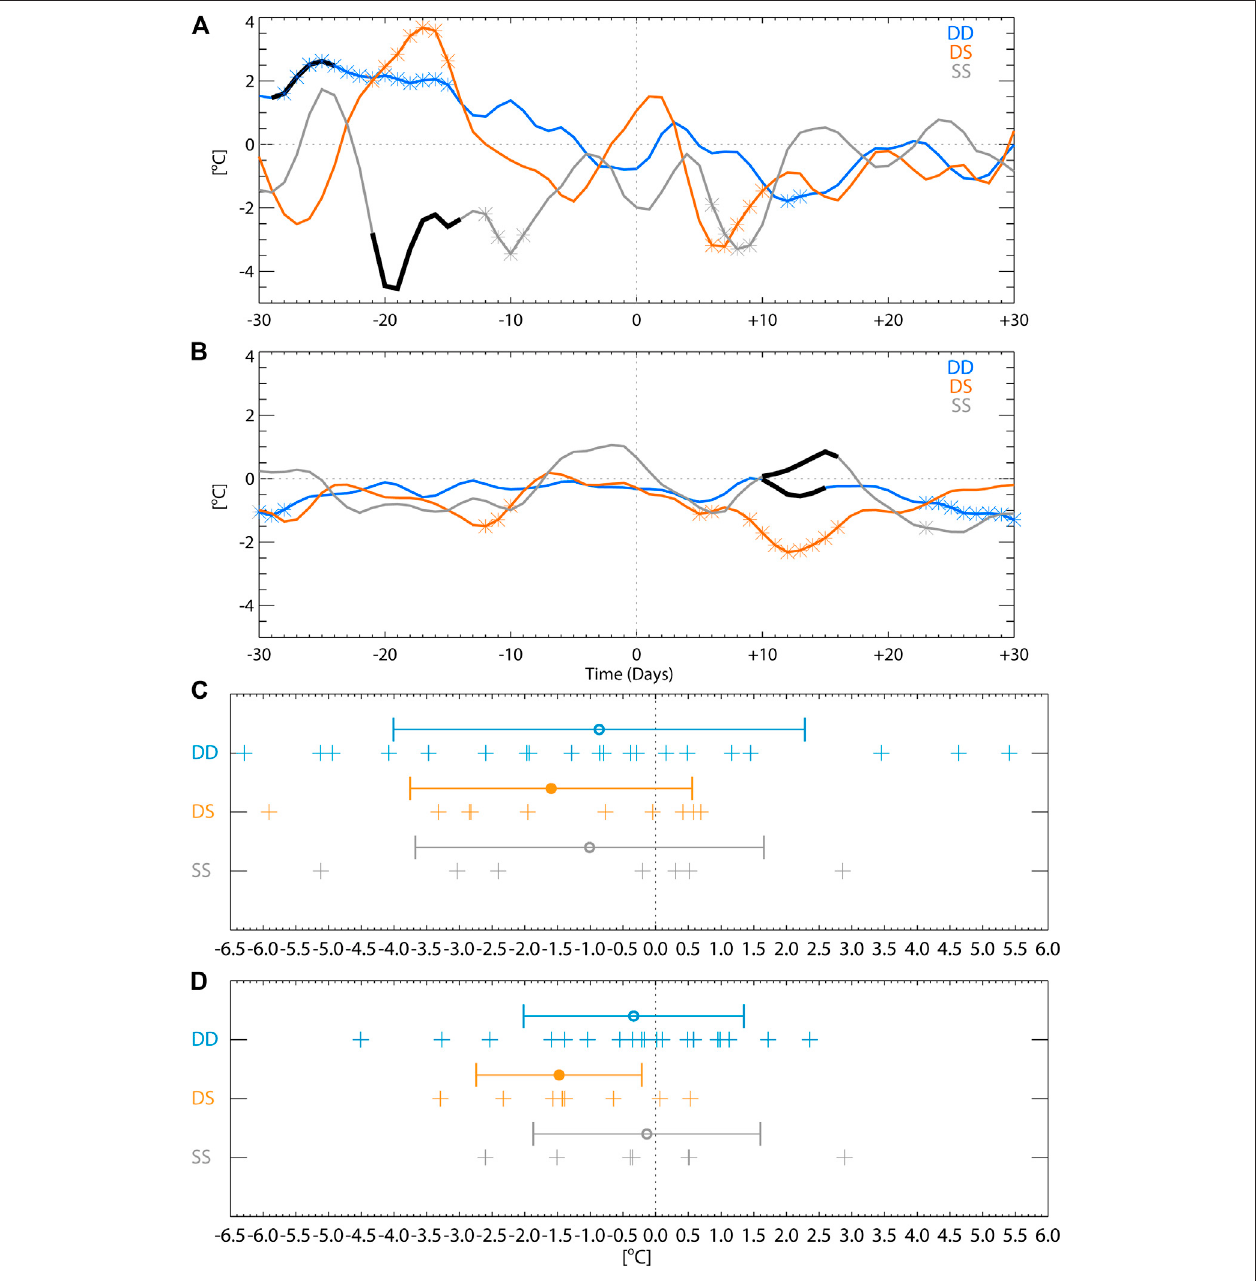
FIGURE 3 | (A) Time series of the 3-day running mean temperature anomaly at 1,000 hPa averaged over (A) North American (80 ° – 120 ° W, 40 ° N – 55 ° N) and (B) Scandinavia/Northern Europe (40 ° W-40 ° E, 60 ° N-75 ° N). Blue, orange, and gray lines denote DD, DS, and SS SSW types, respectively. The asterisk indicates statistically signi fi cantperiods fromazero at90%con fi dencelevel.Theblackbold solidpart indicateswhen theDSminus DDandDSminus SSdifferencesaresigni fi cantlydifferent at 90% con fi dence level, respectively. Scatter plot of temperature anomaly at 1,000 hPa over (C) North America and (D) Scandinavia/Northern Europe occurring during thethreeSSWtypes. Thetemperature anomalyisaveragedoverdays 5to20.Themeantemperature anomalyforeach typeisdenoted byaclosed circlewithan error bar, indicating one standard deviation. The fi lled circle represents a statistically signi fi cant value at a 90% con fi dence